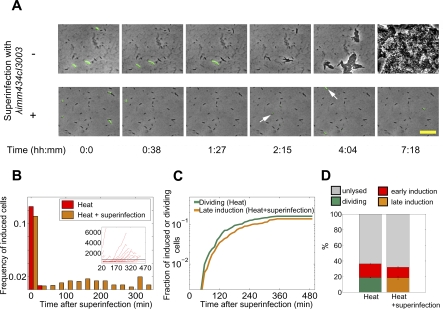
Exit from Dormancy Is Required for Phage-Mediated Lysis(A) Superposition of phase-contrast and fluorescence images acquired by time-lapse microscopy of the hipA7 λcI857KnR lysogens after heat induction, without (upper panel) and with (lower panel) λimm434cI3003 phage superinfection. Fluorescence expression of the pR′-tR′-gfp fusion is monitored. At the end of the measurements, no survival is observed in the superinfected cells (namely, no dividing cells), whereas several dividing cells can be seen in the noninfected cells. The arrows point to the location of a superinfected bacterium with late onset of fluorescence. Scale bar indicates 20 μm.(B–D) Single-cell analysis of hipA7 λcI857KnR lysogens following heat induction, with and without phage superinfection. (B) Timing of the onset of pR′-tR′-gfp activation. Histograms are normalized to the total number of cells (approx. 1,000 cells each). The initial fast response is analogous to the one presented in Figure 2C and is followed here by a clear spread of onset activation times in the superinfected cells. Inset: typical single-cell fluorescence expression curves. Onset time is defined as where the fluorescence crosses the threshold (black line). (C) Exit from dormancy of superinfected and noninfected lysogens. Persisters to heat induction in both conditions were followed for either onset of fluorescence (superinfected), or division (noninfected). The time dependence of both processes is similar, showing that exit from dormancy is required for activation of the lytic program. (D) Relative percentage of the different outcomes of heat induction, with and without phage superinfection, observed by phase and fluorescence microscopy. Error bars represent the standard deviation between two separate microscopy experiments.